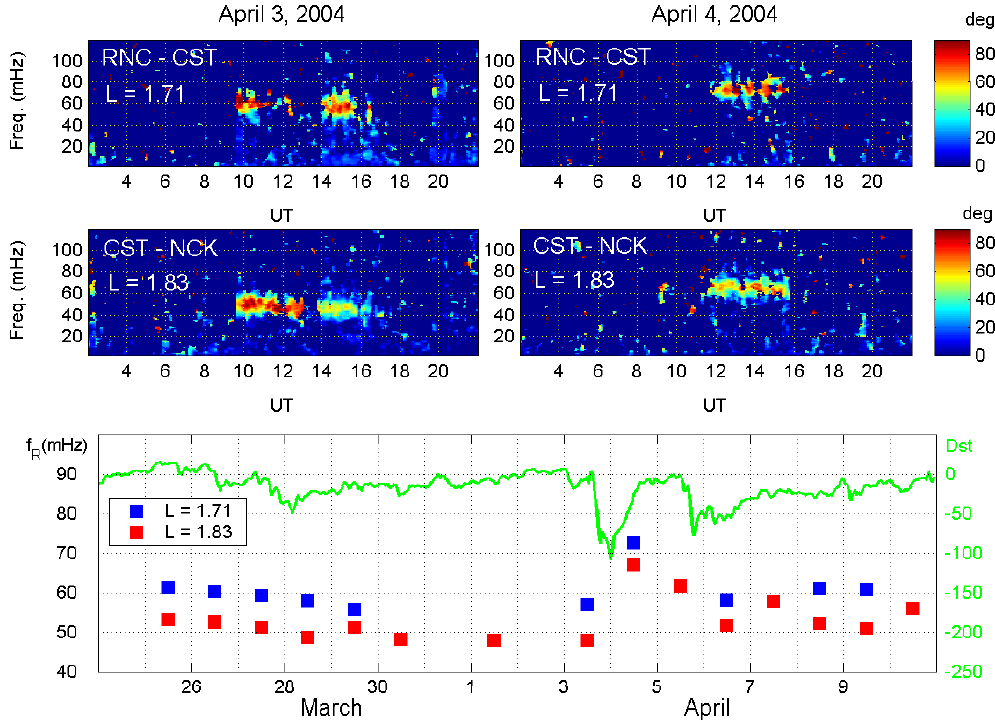
Fig. 5. Top: Dynamic cross-phase spectra of the H component for two station pairs of the SEGMA array. Bottom: D st index (green line) and daily averages (over the daytime interval 09:00–16:00 LT) of the resonant frequency at L =1.83 (red squares) and 1.71 (blue